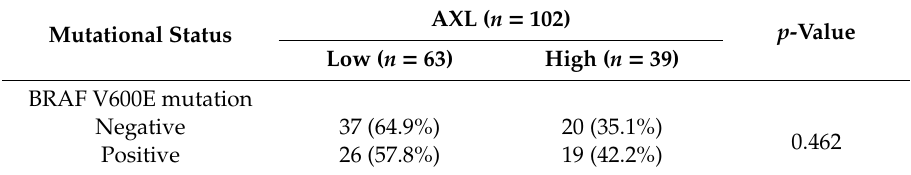
Table 3. Relation between AXL expression and BRAF V600E mutational